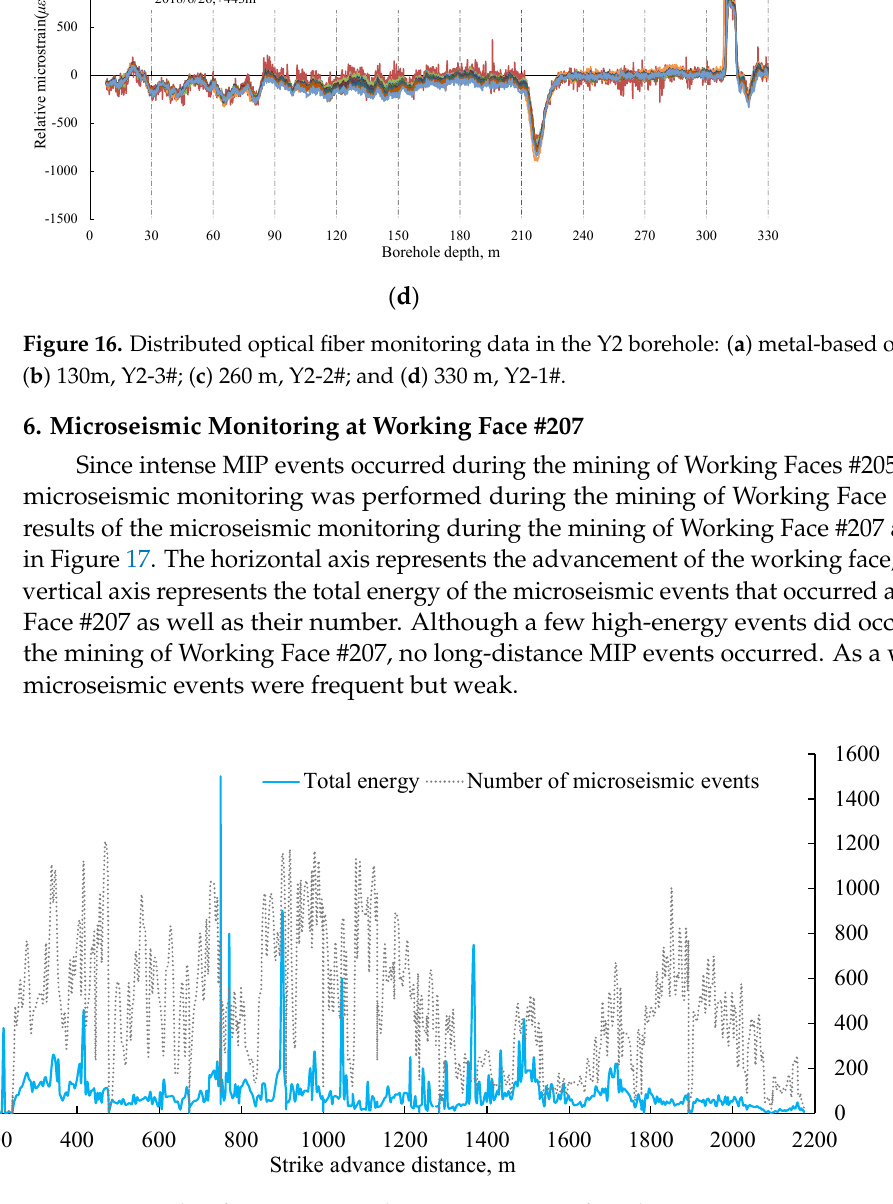
Figure 17. Monitoring results of microseism in the mining process of Working Face #207. Based on these results and the previously described internal strata movement, we can conclude that the Luohe Formation UTHS had already fractured before Working Face #207 was mined. Furthermore, the Luohe Formation UTHS subsided continuously during the mining of Working Face #207 rather than was “dangling” above the goaf. Consequently, there was no risk of a large and sudden break in the UTHS. The results of this paper have provided useful information for assessing the risk of mining Working Face #207, the aforementioned conclusions of which have been validated during the mining of this working face. The knowledge gained in this paper has ultimately allowed Working Face #207 to be mined